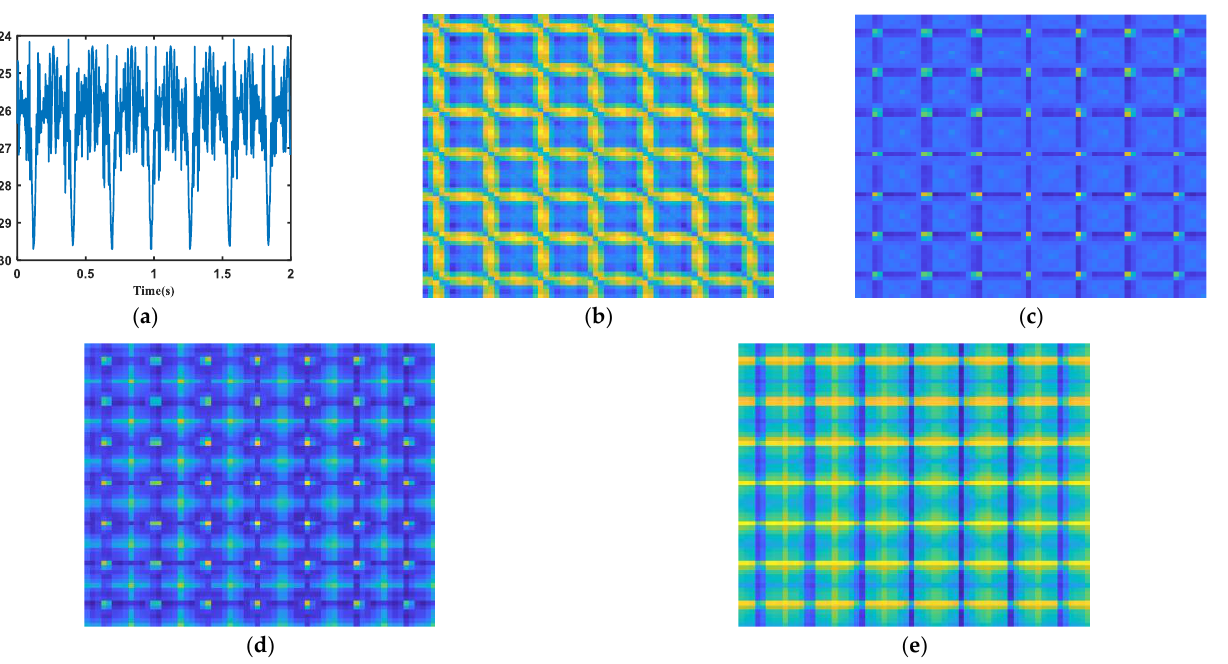
Figure 4. ( a ) RCS; ( b ) RP; ( c ) MTF; ( d ) GASF; ( e ) GADF . RCS sequences encoding of the warhead.